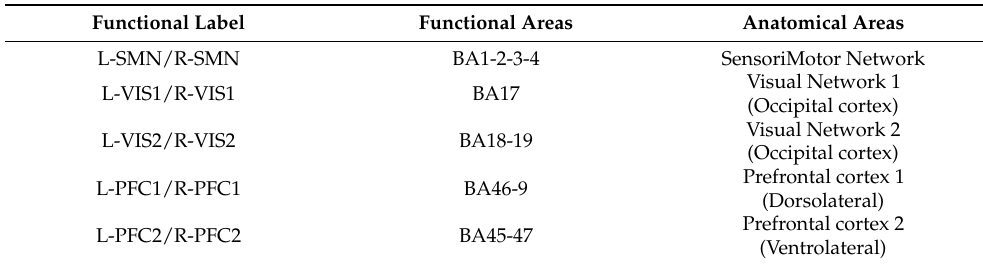
Table 2. Summary of employed left (L-) and right (R-) hemisphere areas and their correspondence between Brodmann areas and anatomical areas.